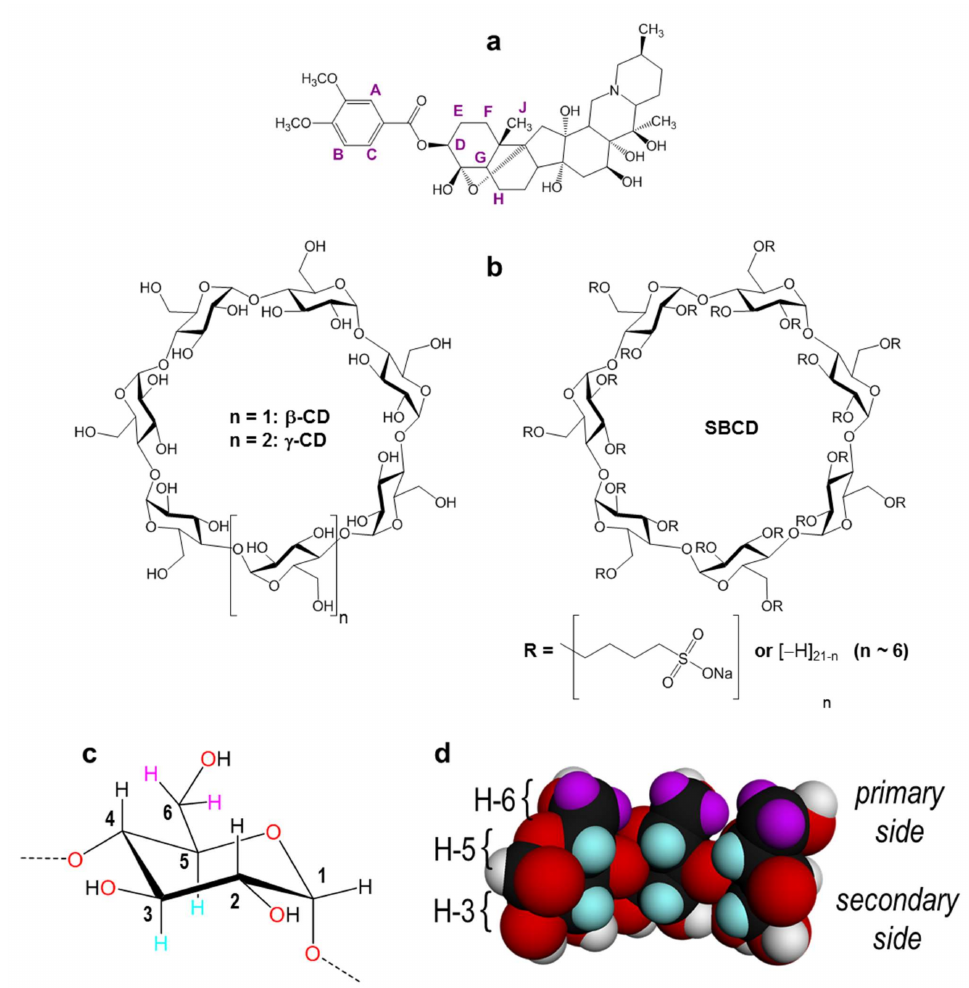
Figure 1. ( a ) Structure of VTD with atom labelling. ( b ) Structure of the cyclodextrin hosts used in this work. ( c ) Atom labelling of the glucopyranose ring. ( d ) Cross-section view from inside the β -CD cavity showing the H-3 and H-5 rims (cyan) and the H-6 atoms located on the border of the primary side